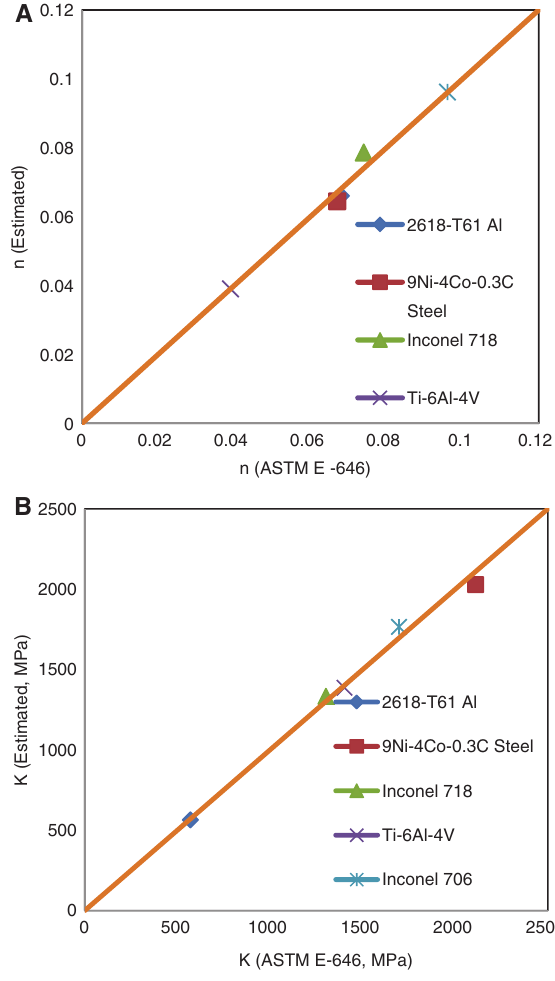
Figure 3 Variation of the ratio of strength co-efficient K to 0.2%